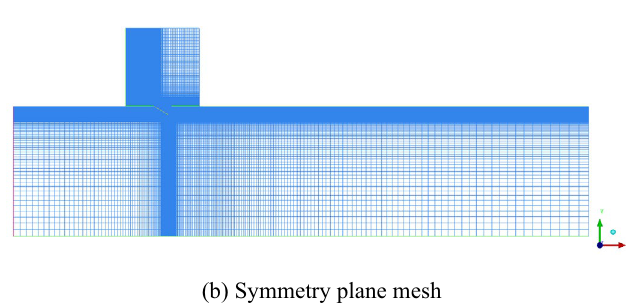
Figure 8. Meshes used for the calculation